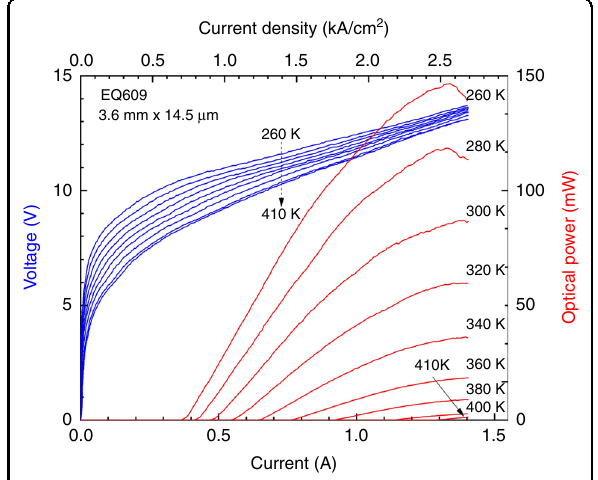
Fig. 14 Voltage – current and light – current characteristics of a QCL grown on a Si substrate measured in pulsed mode at different temperatures. Reprinted from ref. 34 , used in accordance